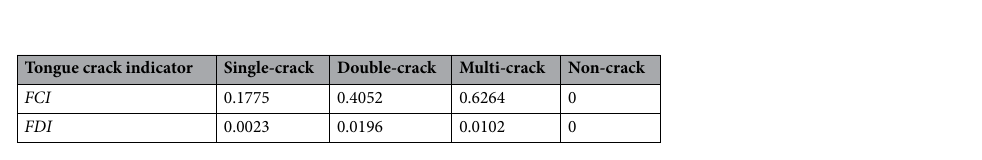
Table 4. The results of tongue crack